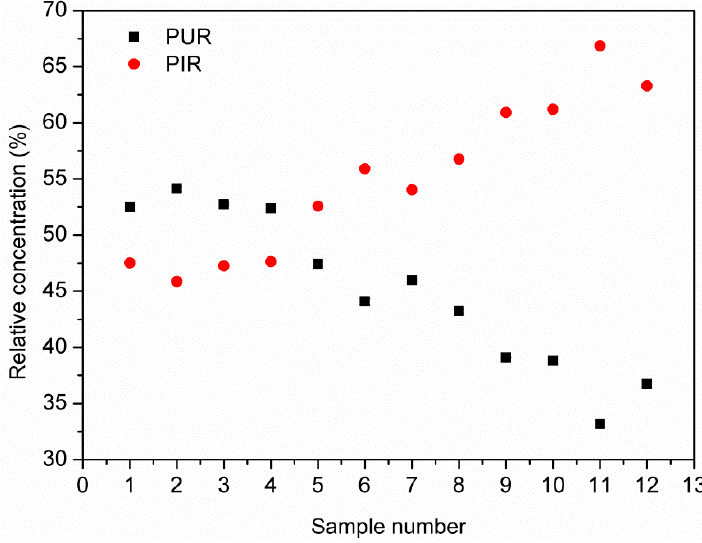
Figure 9. Relative concentrations of major factors.